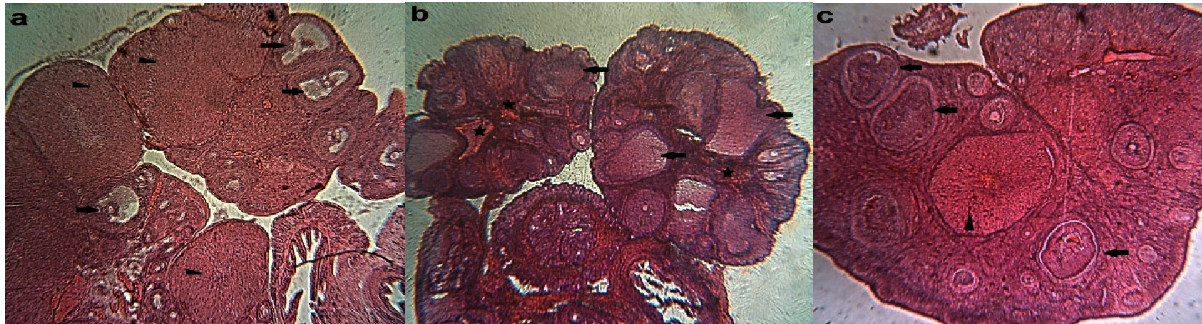
Figure 1. Histological analysis showing ( a ) normal, ( b ) PCOS and ( c ) BV-treated PCOS ovaries. Ovarian sections were stained with hematoxylin and eosin. An increase in the number of cysts (arrow), lack of corpus luteum (arrow head), and increased levels of ovarian stroma (star) in panel b is compared with panel a . In panel c , a decrease in the number of cysts and the ovarian stroma level, and the appearance of a corpus luteum can be detected.